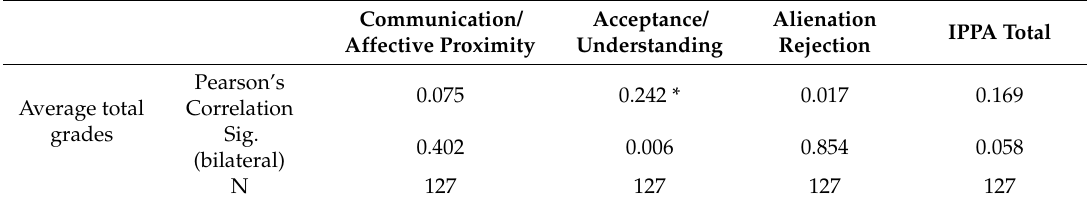
Table 9. Correlation between the student–teacher relations subscale with the average of the total grades, in